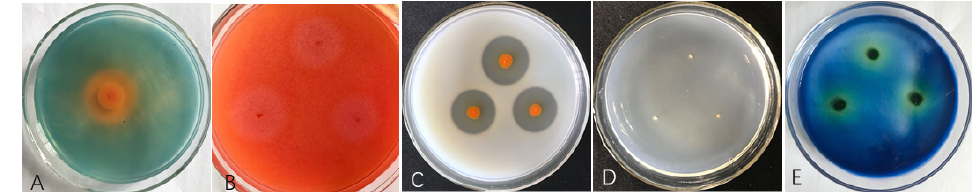
Figure 2. Fungal cell-wall-degrading enzymes produced by ST-TJ4 cells. ( A ) Siderophores on CAS plates; ( B ) cellulase activity on carboxyl methyl cellulose (CMC) plates; ( C ) protease activity on SMP plates; ( D ) chitinase activity on colloidal chitin agar plates and ( E ) glucanase activity on Pachyman plates;